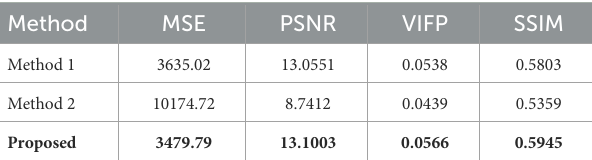
TABLE 1 Performance of our method compared with other methods from macaque V1 spike